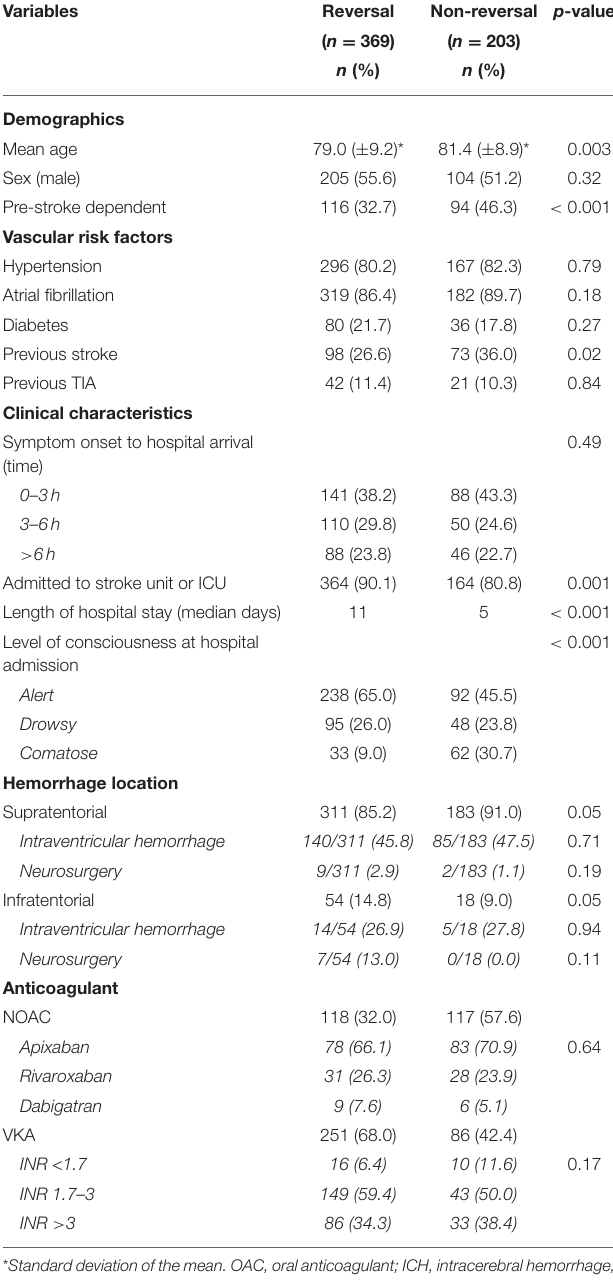
TABLE 1 | Baseline characteristics of 572 patients with OAC-ICH comparing patients that received reversal treatment compared to patients who did not receive reversal